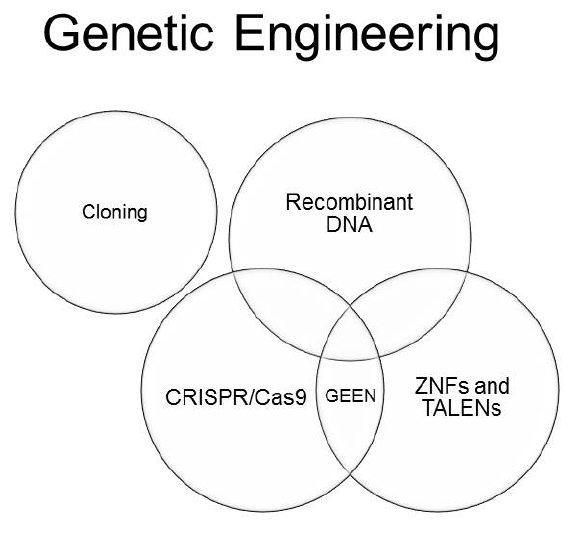
Figure 1: Genetic engineering (GE) involves the manipulation and/ or modification of the genome of living beings, for 3 decades recom- binant DNA remained the main tool of GE but recently, engineered endonucleases (GEEN) such as ZFNs and TALENs have proved to be a more precise and efficient tool, the discovery of the CRISPR/ Cas9 system took this one step further, revolutionizing GE. To differentiate from recombinant DNA technology, the modification of genomes using endonucleases is known as genome editing. Despite not involving modification of the genome, cloning is considered by many a type of